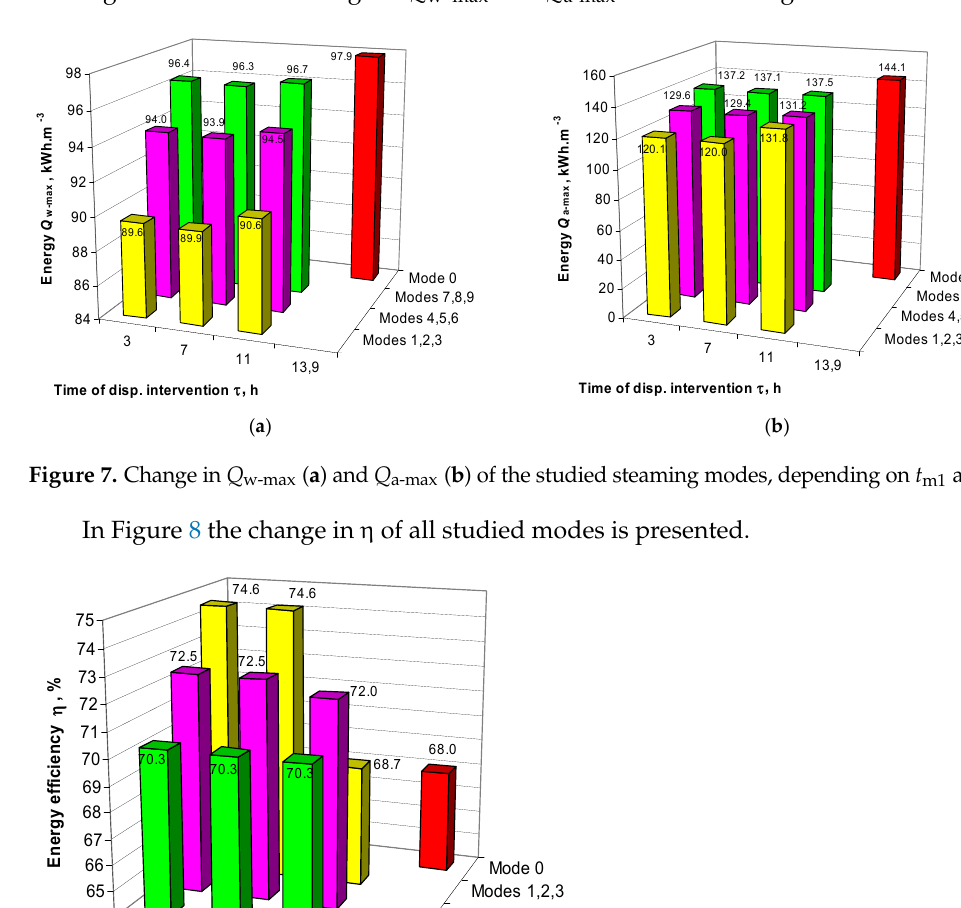
Figure 6. Changes in t m , Q a , and Q w during steaming modes 0, 7, 8, and 9, depending on τ . In Table 2, the change in τ 2 = τ steam , and τ 4 = τ mode (see Figure 2) of all modes, and also of the t w ‐ avg , Q w ‐ max , Q a ‐ max , and η is given. Figure 7 shows the change in Q w ‐‐ max and Q a ‐ max for all steaming modes.